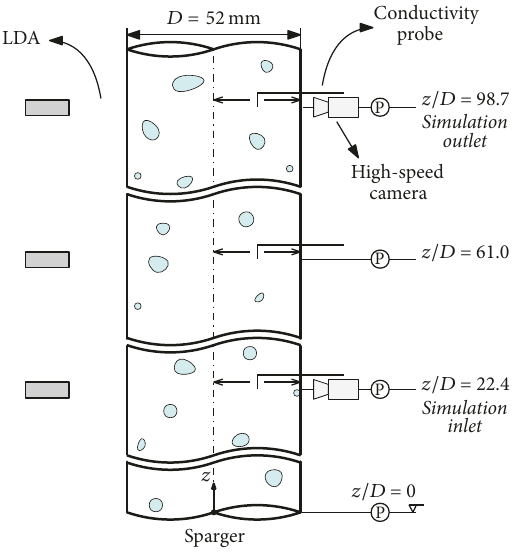
Figure 2: Experimental test rig for the pipe including the measure- ment techniques